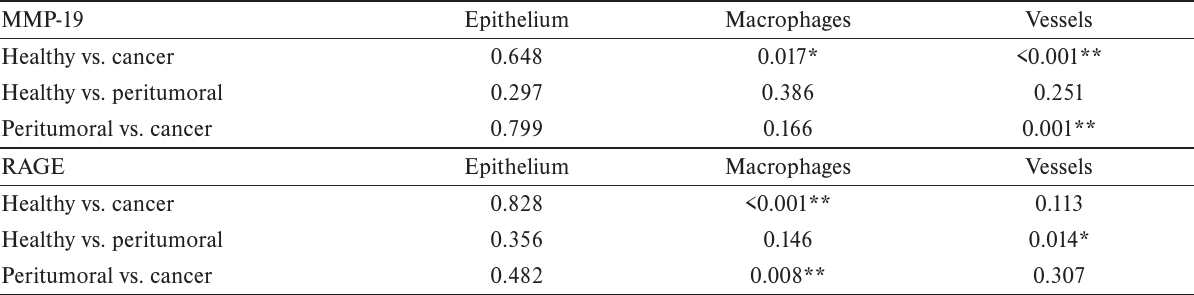
Table 3. Expression of MMP-19 and RAGE within the CRC